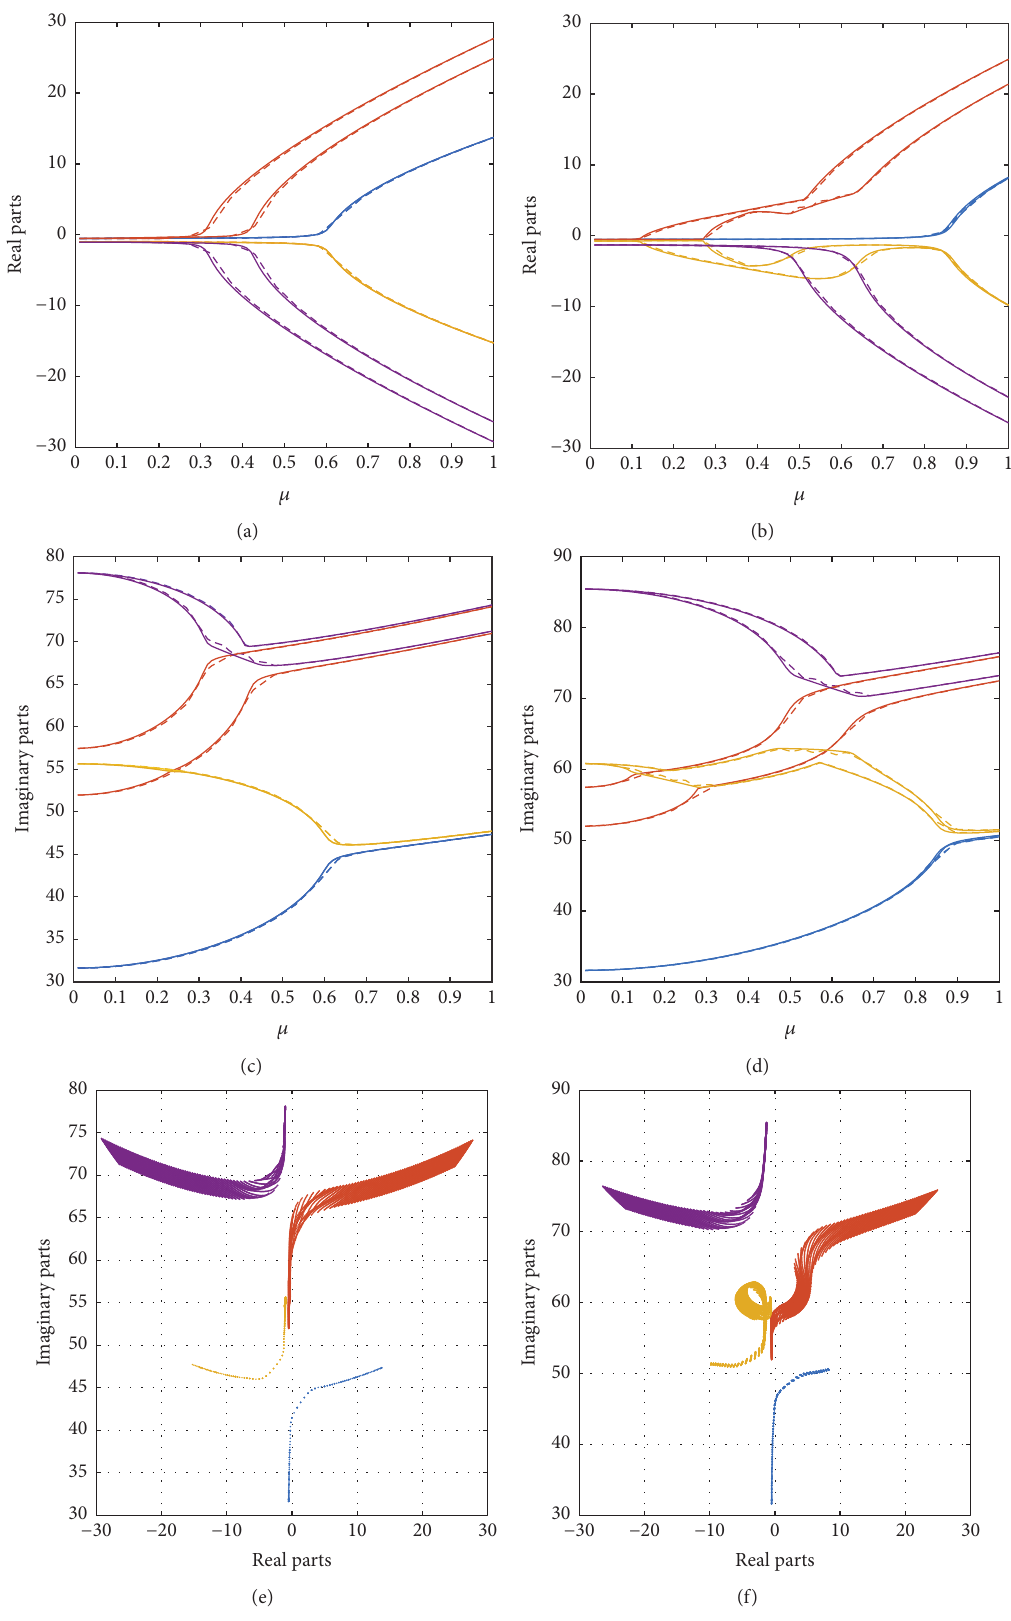
Figure 6: Kriging (--) on two-dimensional parameter space with a 2D linear sample grid (20 × 50) compared to deterministic results ( − ): real (a, b) and imaginary (c, d) parts of eigenvalues versus 𝜇 for configurations 1 (a, c) and 2 (b, d). Evolution in the complex plan based on kriging metamodel for configurations 1 (e) and 2